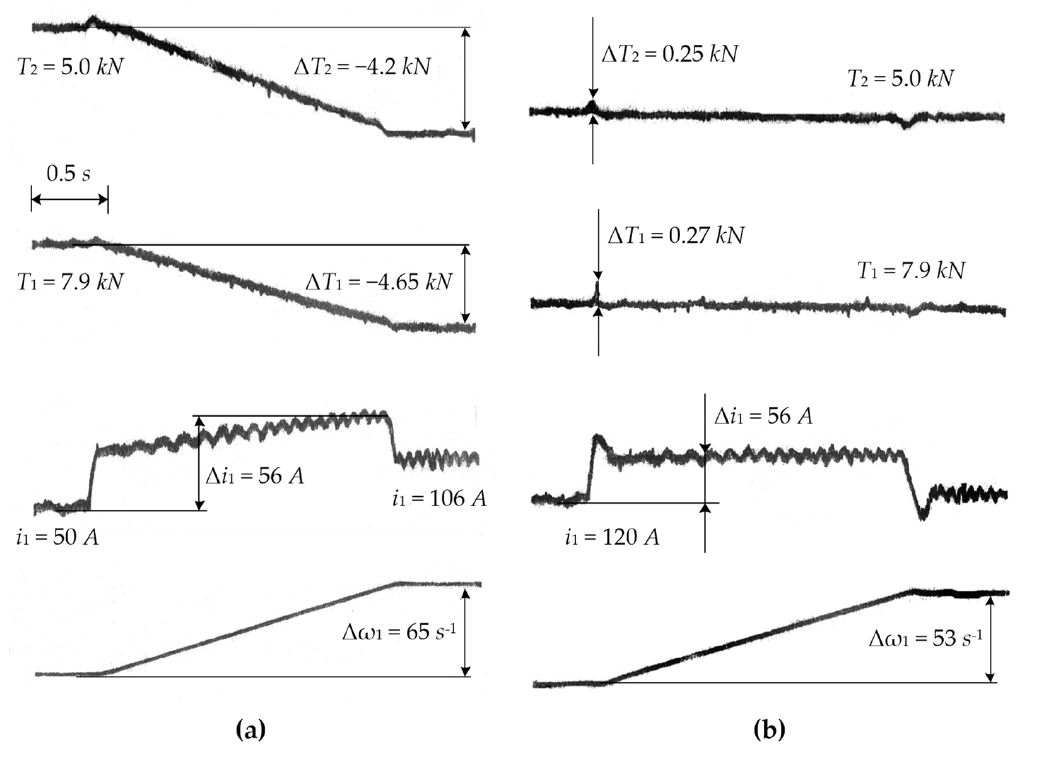
Figure 8. Figure 8. Mill Acceleration Transient Processes for the Existing ( a ) and Developed ( b ) Control Sys- tems. ( b ) Control